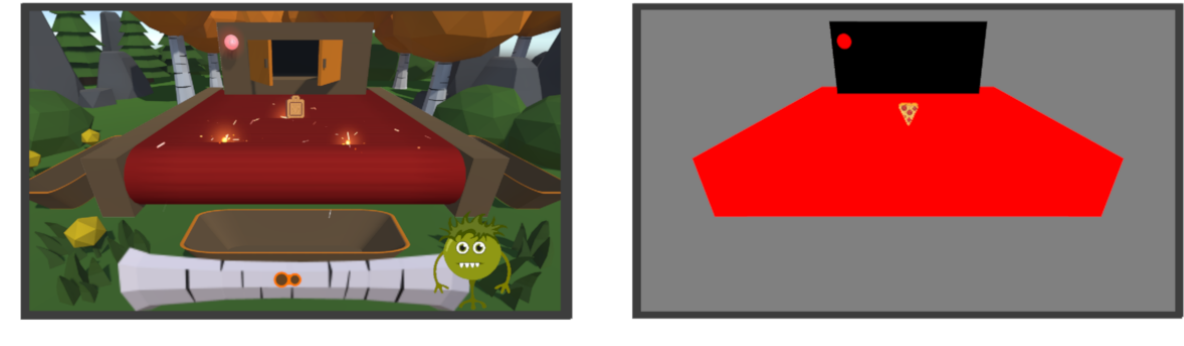
Figure 3. The stimuli. Left: 4 red targets—French fries, glove, scissors, and pizza. Right: 4 brown targets—wooden hammer, cake, chopping board, and donut. Pixel art stimuli were selected for their low-poly, 8-bit style. Stimuli were created by artist VectorPixelStar [30] and used in agreement with the artist in this